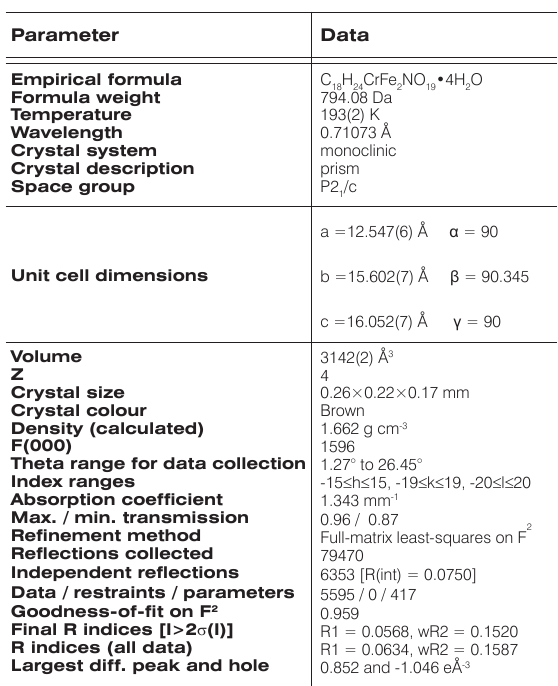
Table 2. Crystal data and structure refinement for 1